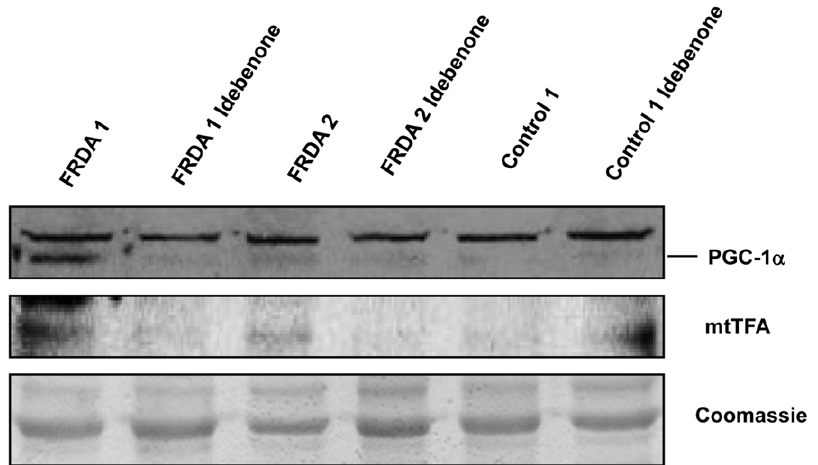
Figure 6. Western blot of PGC-1 a and mtTFA after treatment with idebenone. Samples were obtained from FRDA 1 and 2 and Control1 fibroblasts incubated with 5 m M of Idebenone during 5 days in 5% CO 2 in air at 37 u C at density of 20,000 cells/cm 2 .